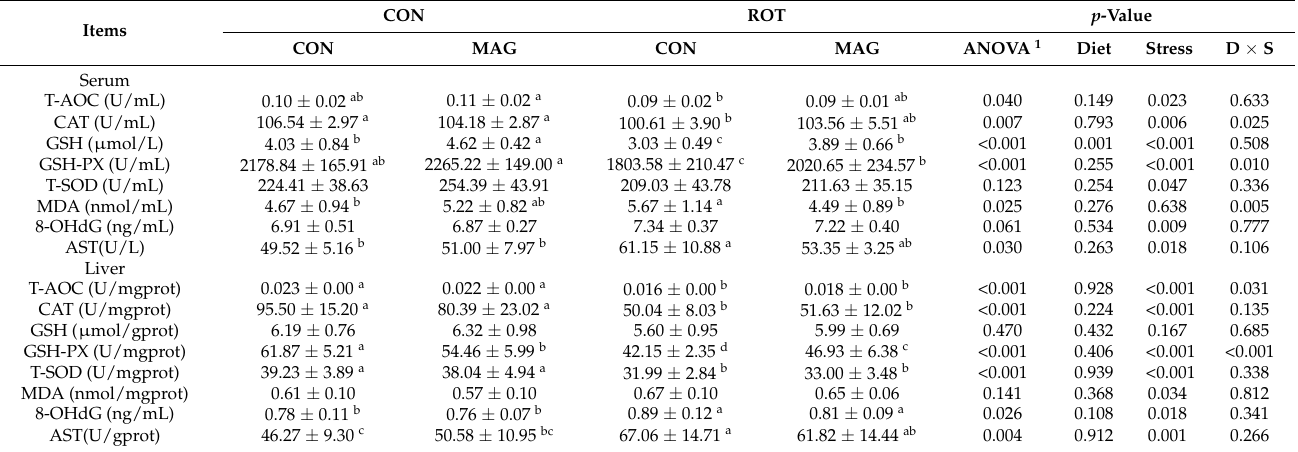
Table 4. Effect of dietary magnolol supplementation on the oxidative parameters in serum and liver under rotenone